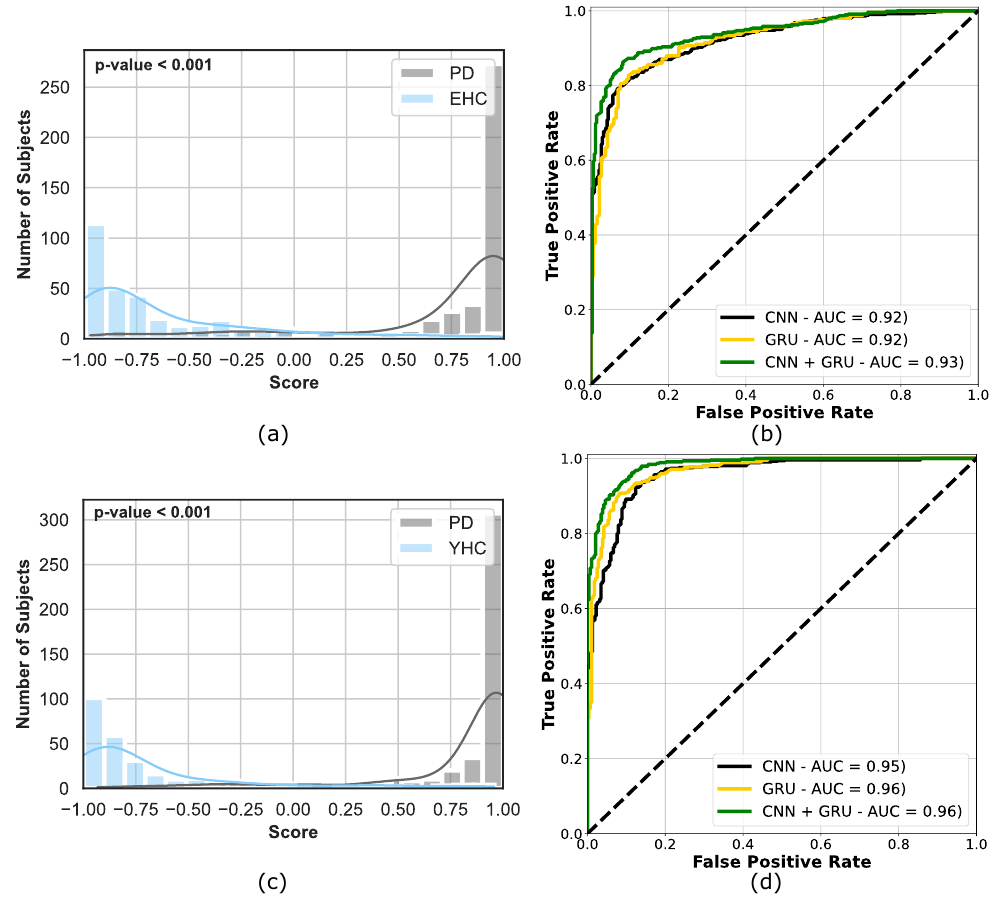
Figure 12. Comparison of the best results considering the 4 × 10 m task and both feet. ( a ) Distribution of the scores in PD vs. EHC using the GRU + CNN architecture. ( b ) Comparison of the ROC curves in the PD vs. EHC scenario. ( c ) Distribution of the scores in PD vs. YHC using the GRU + CNN architecture. ( d ) Comparison of the ROC curves in the PD vs. YHC